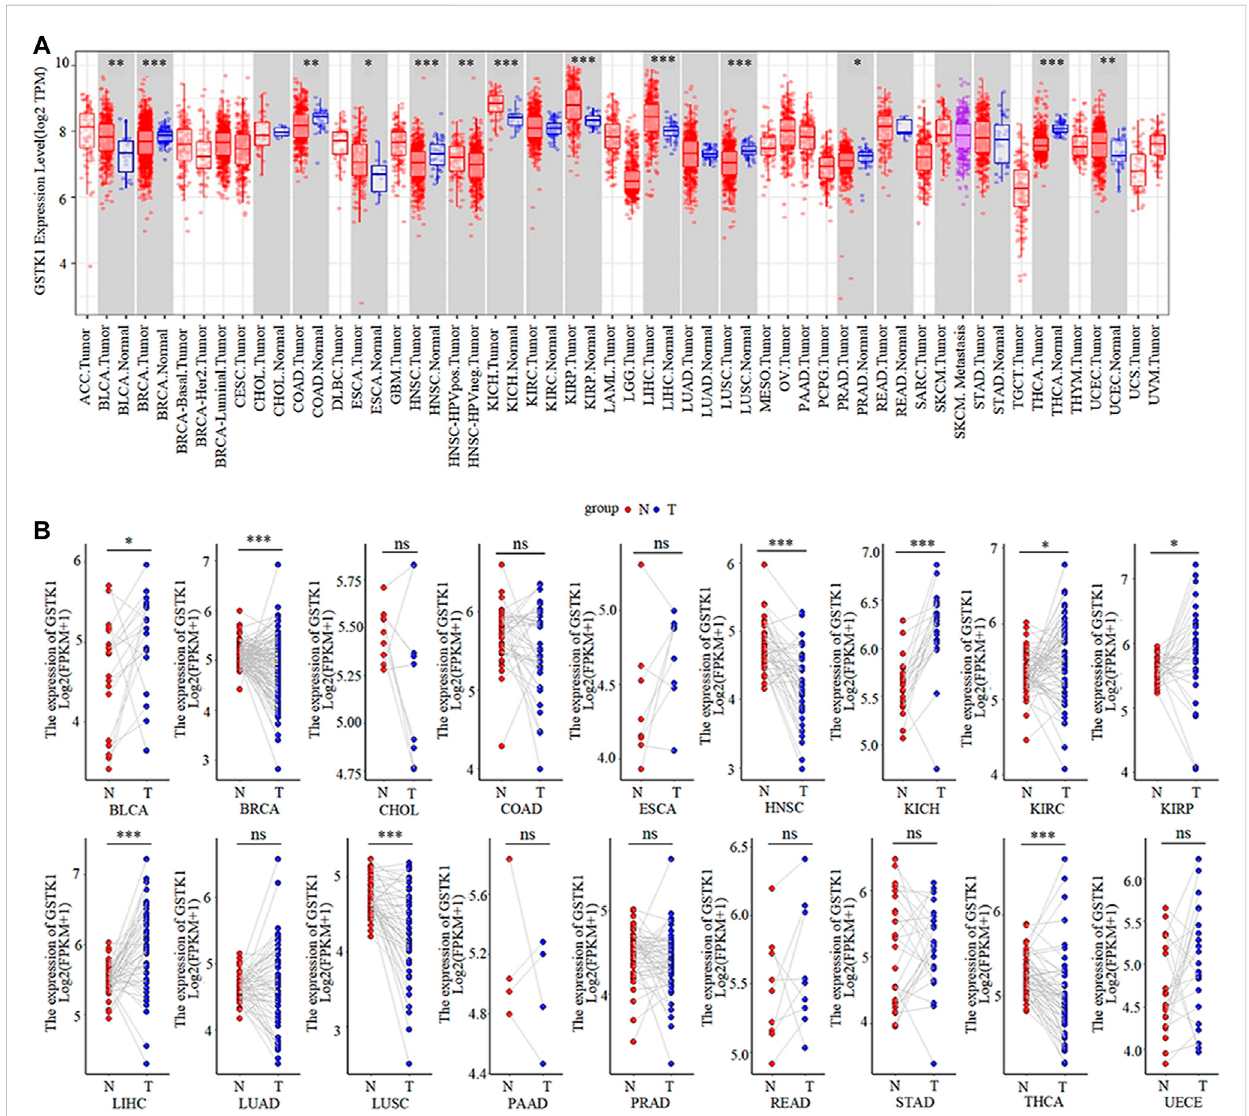
FIGURE 1 GSTK1 expression in various types of human cancers (A) Comparison of the GSTK1 expression between variouscancers and normal tissue using the TIMER database. (B) GSTK1 expression of several cancers vs. paired normal tissue from the TCGA database. (* p < 0.05, ** p < 0.01, *** p < 0.001). (ACC: adrenocortical carcinoma; BLCA: bladder urothelial carcinoma; BRCA, breast invasive carcinoma; CESC, cervical squamous cell carcinoma; CHOL: cholangiocarcinoma; COAD: colon adenocarcinoma; DLBC, lymphoid neoplasm diffuse large B cell lymphoma; ESCA, esophageal carcinoma; GBM, glioblastoma; LGG, brain lower grade glioma; HNSC, head and neck squamous cell carcinoma; KICH, kidney chromophobe; KIRC, kidney renal clear cell carcinoma; KIRP, kidney renal papillary cell carcinoma; LAML, acute myeloid leukemia; LIHC, liver hepatocellular carcinoma; LUAD, lung adenocarcinoma; LUSC, lung squamous cell carcinoma; MESO, mesothelioma; OV, ovarian serous cystadenocarcinoma; PAAD, pancreatic adenocarcinoma; PCPG, pheochromocytoma and paraganglioma; PRAD, prostate adenocarcinoma; READ, rectum adenocarcinoma; SARC, sarcoma; SKCM, skin cutaneous melanoma; STAD, stomach adenocarcinoma; TGCT, testicular germ cell tumors; THCA, thyroid carcinoma; THYM, thymoma; UCEC, uterine corpus endometrial carcinoma; UCS, uterine carcinosarcoma; UVM, uveal